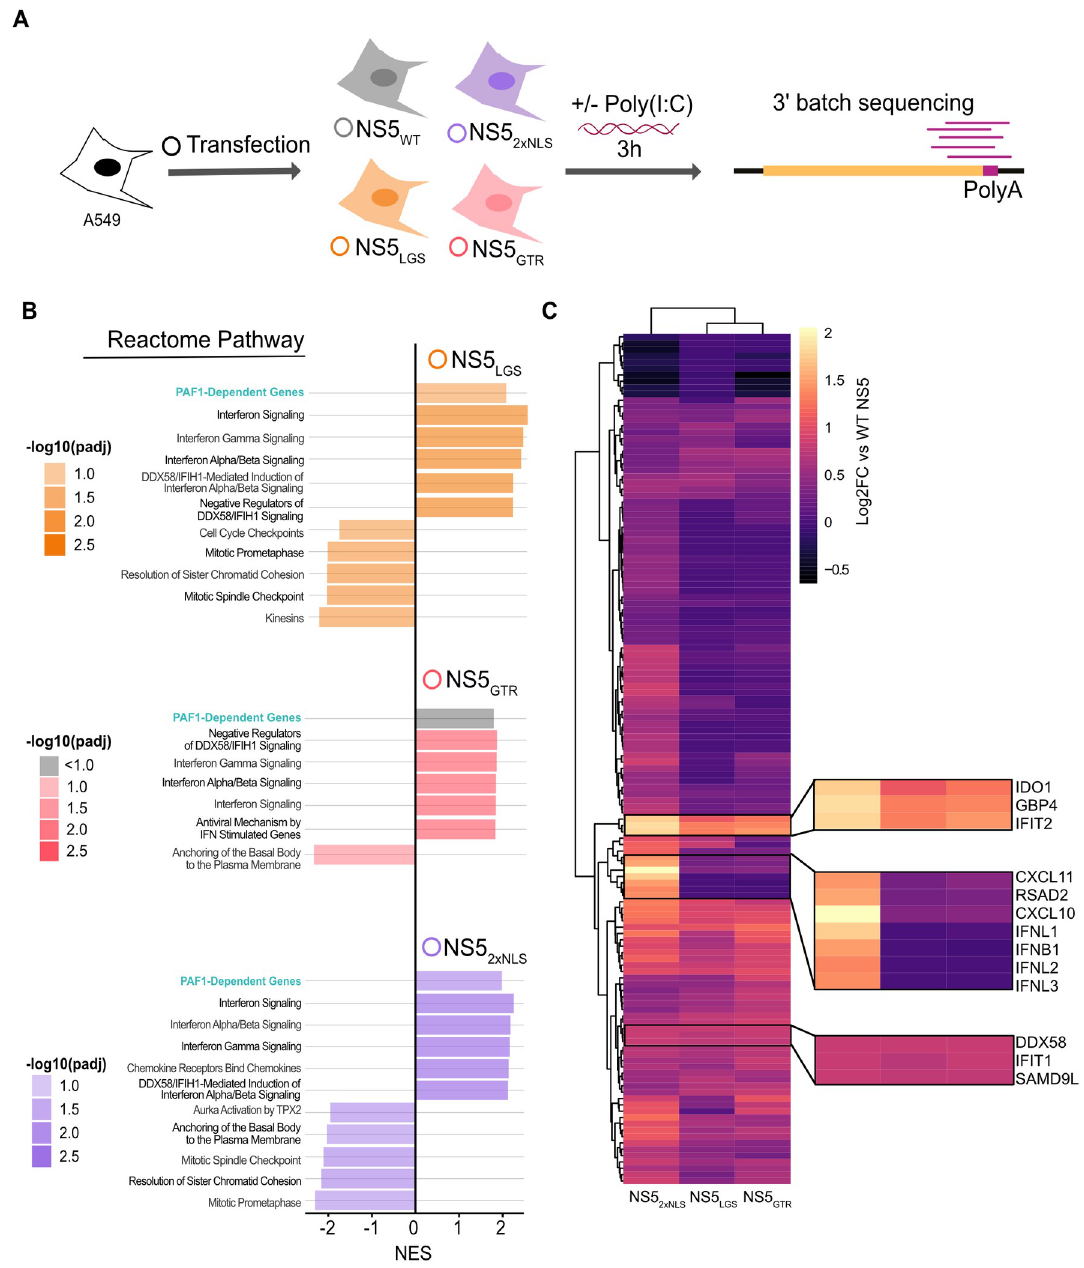
Fig 6. NS5 mutants have shared and distinct impacts on gene expression. (A) Parental A549 cells were transfected with NS5 WT (grey), NS5 2xNLS (purple), NS5 LGS (orange), NS5 GTR (red), or GFP as a negative control. Transfected cells were stimulated with poly(I: C) for three hours and subjected to RNA-seq. Results are based on three independent biological replicates. (B) GSEA was conducted on genes differentially expressed by cells expressing WT versus mutant NS5s. Up to the top 5 positively and negatively enriched Reactome pathways were plotted for each comparison (p adj < 0.1). A full list of GSEA results is available in S2 Table. (C) Genes significantly upregulated in NS5 2xNLS versus WT NS5 (log2 fold change > 0.5, p adj < 0.05) were subjected to hierarchical clustering for each mutant and displayed as a heat map. Genes of interest are highlighted by zoom panels.